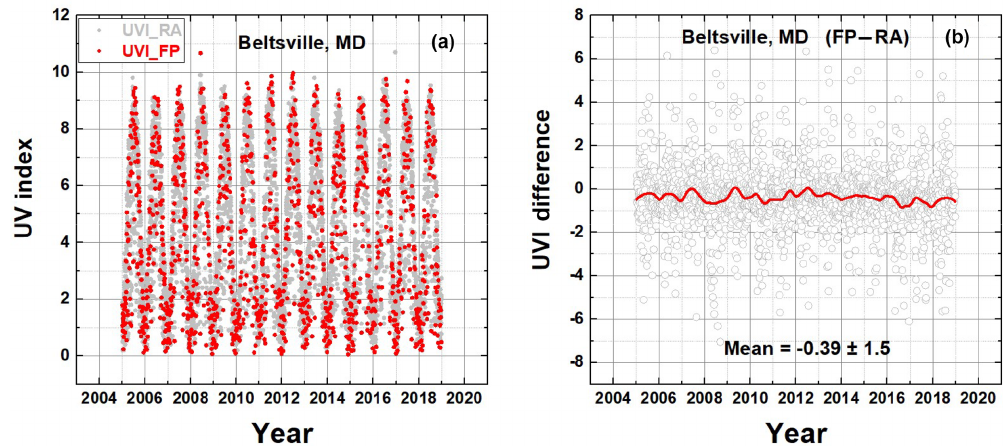
Figure 1. A comparison of the OMI erythemal irradiance algorithm (RA) with the fast polynomial algorithm (FP) for Beltsville, Maryland. (a) are the time series. (b) is the difference FP–RA. The red line is approximately a 1-year Loess(0.1) fit to the data.